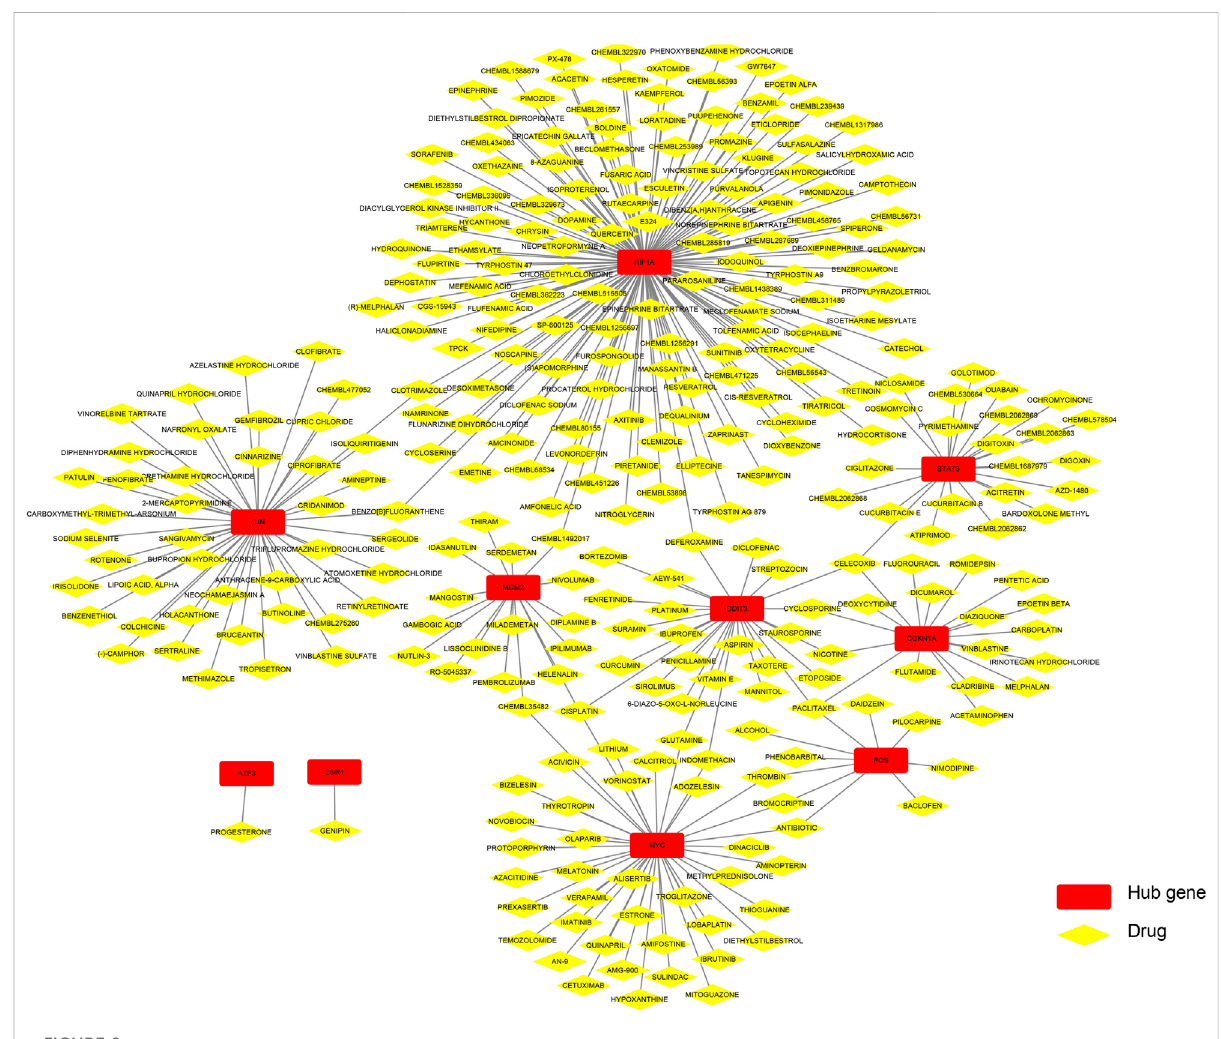
FIGURE 9 Construction of the drug – hub gene interaction